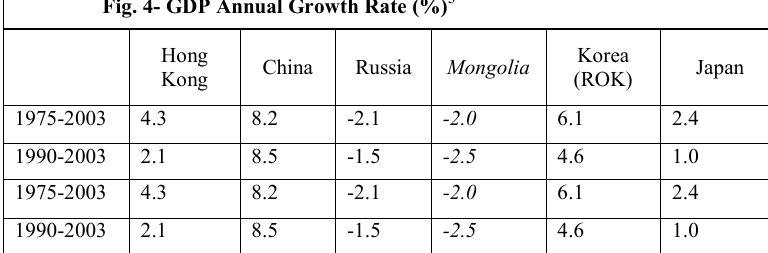
Fig. 4- GDP Annual Growth Rate (%)